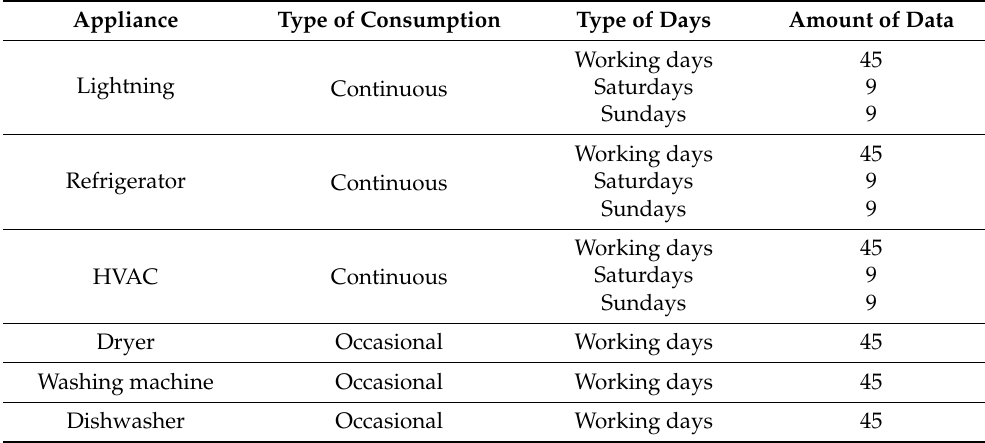
Table 3. Summary of the evaluated appliances with their type of consumption, type of days and amount of